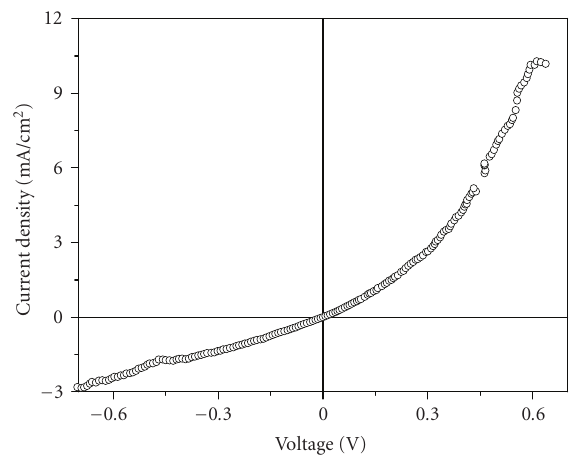
Figure 7: Current-voltage characteristic of ITO/POT/Al devices. Figure 8: Experimental I-V characteristic of ITO/POT/Al devices ( ◦ ) and fits (line) using (4) in the forward bias